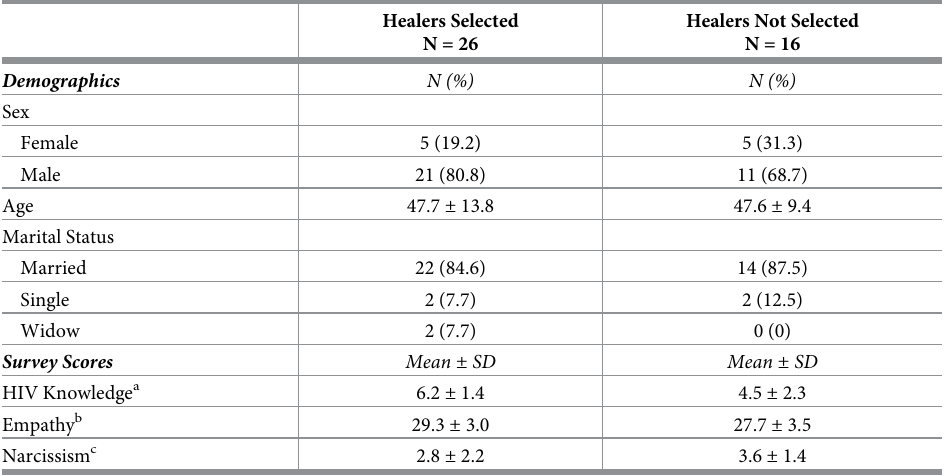
Table 2. Healer characteristics at baseline.